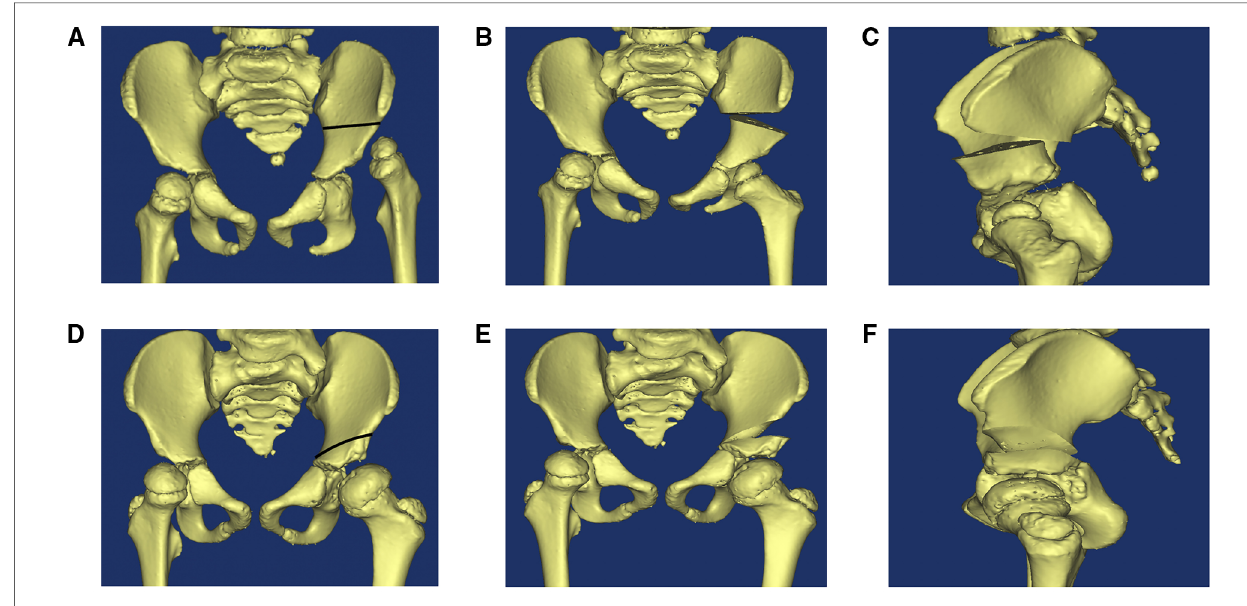
FIGURE 1 Salter pelvic osteotomy and Pemberton osteotomy. ( A ) The osteotomy line of Salter pelvic osteotomy (blank line). ( B ) Anteroposterior view of pelvic after salter osteotomy. ( C ) Lateral view of pelvic after salter osteotomy. ( D ) The osteotomy line of Pemberton osteotomy (blank line). ( E ) Anteroposterior view of pelvic after pemberton osteotomy. ( F ) Lateral view of pelvic after pemberton